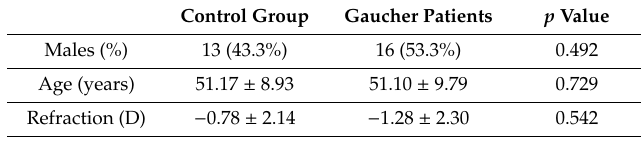
Table 1. Demographics and refraction of Gaucher disease patients and controls.